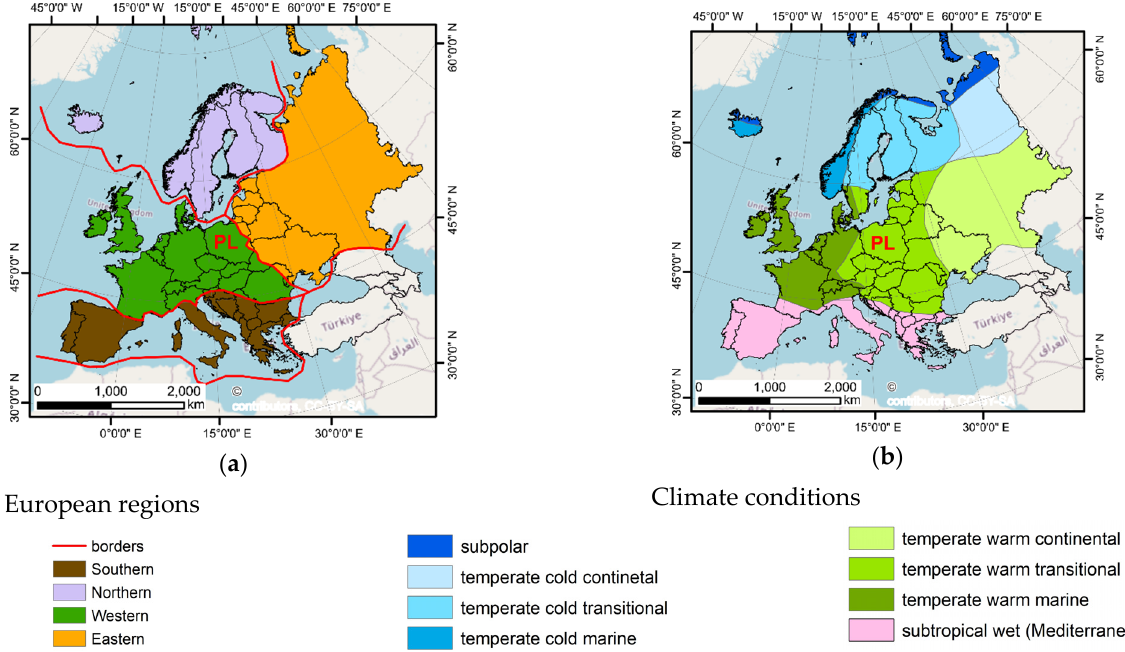
Figure 1. Regions and climatic conditions in Europe: ( a ) map of regions according to the physical and climatic conditions, ( b ) types of climate conditions, PL = Poland (based on Wiking-Educational Publisher, license: CC BY 3.0).